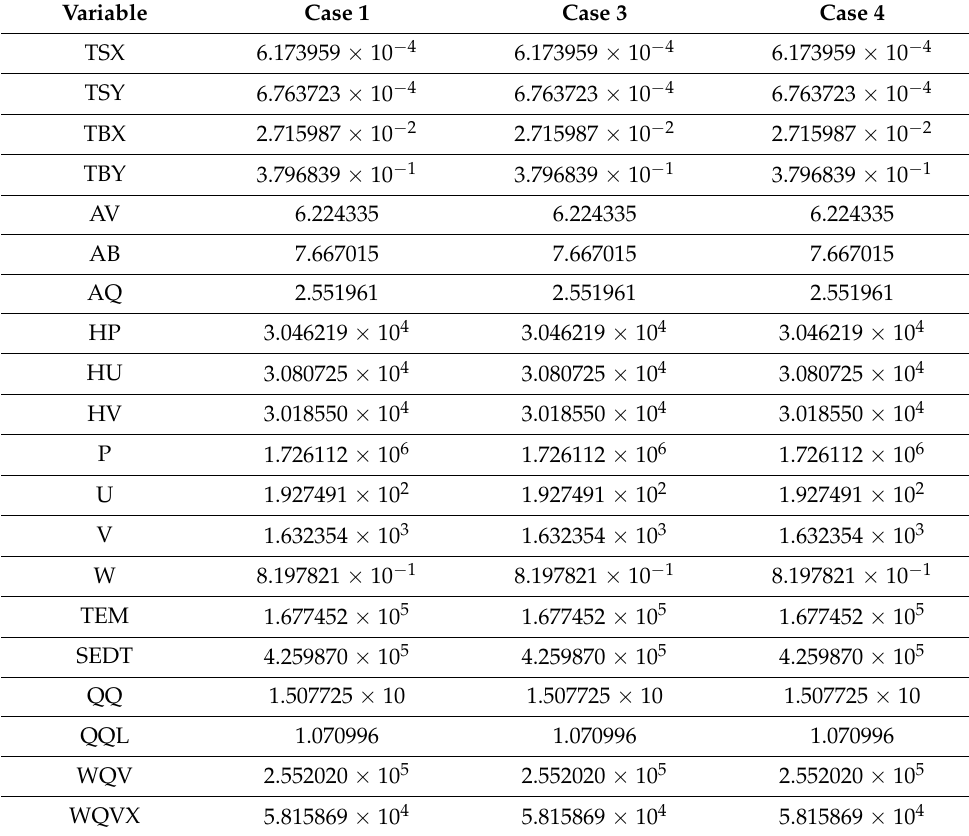
Table 6. Consistency analysis results for each evaluation